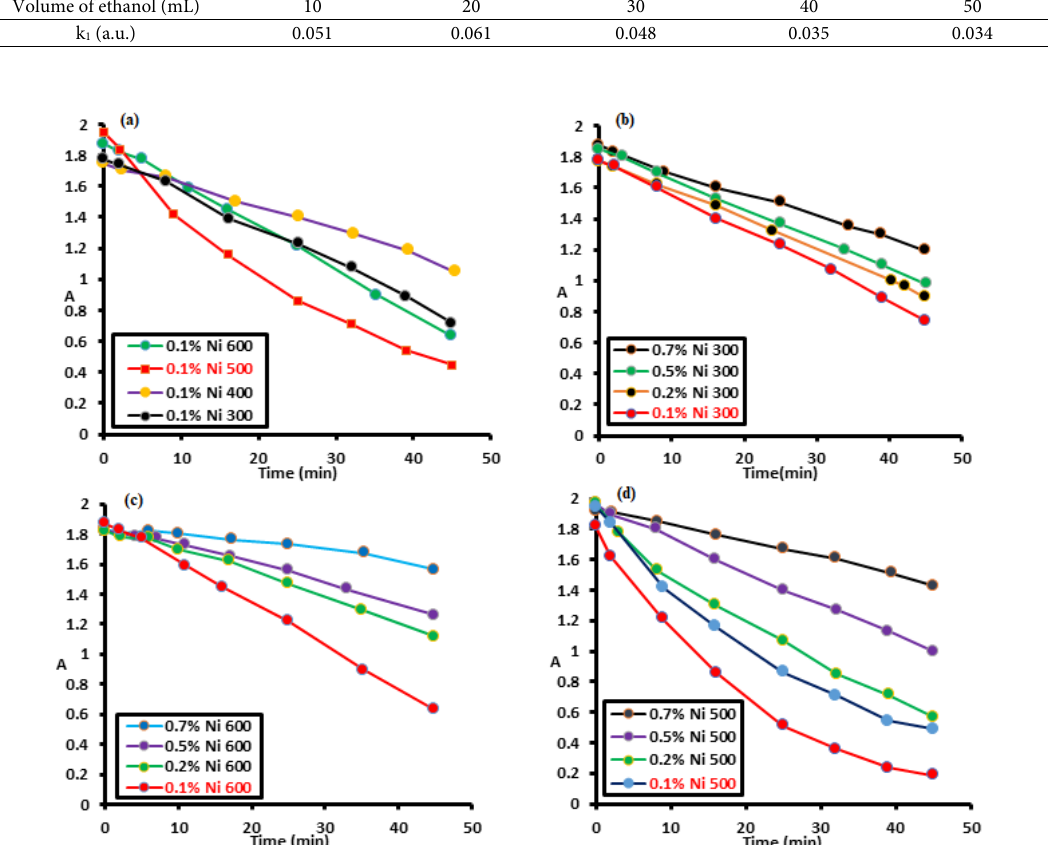
Fig. 12. Photocatalytic degradation of E131 VF in presence of Nickel doped TiO